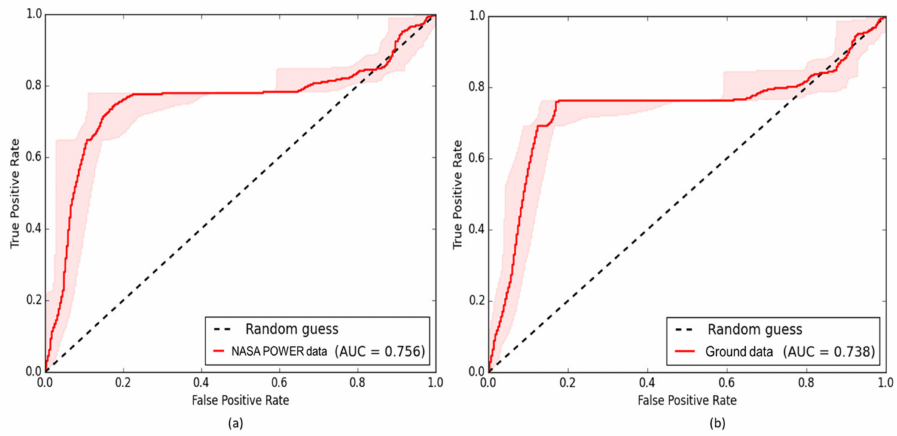
Figure 8. AUC graph ( a ) NASA POWER data, ( b ) ground-measured